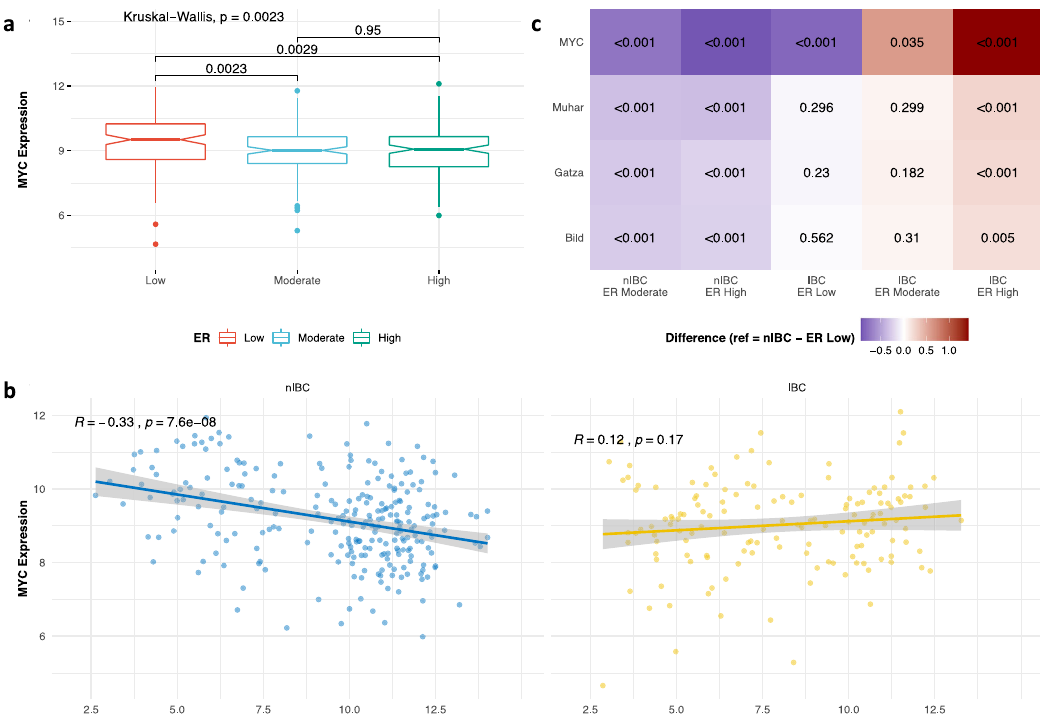
Fig. 4 MYC expression and transcriptional activity in patient samples in function of ESR1. a MYC expression levels (Y-axis) in a data set of 146 IBC and 252 nIBC tissue samples classi fi ed according to the ER status, calculated by stratifying ESR1 mRNA levels into low, moderate, and high categories. Data are represented in notched boxplot format and color-coding according to the legend shown underneath the plot. P values resulting from the pairwise comparison of the MYC expression distributions between the different tumor sample categories are indicated. b Scatter plot comparing ESR1 and MYC expression, represented in the X- and Y-axis respectively, in nIBC (left) and IBC (right) patient series. For each series, a trend line is plotted and the resulting Spearman correlation coef fi cients are shown in the top left corner. c Heatmap representing the result of a generalized linear regression analysis evaluating MYC expression levels (i.e., top row) and MYC transcriptional activation calculated using the gene sets published by Muhar et al., Gatza et al. and Bild et al. (i.e., bottom 3 rows) in function of the tumor phenotype (i.e., IBC vs. nIBC) and interactions thereof with different strata of ER expression. For each of the resulting categories, shown along the X-axis (i.e., nIBC — ER Moderate, nIBC — ER High, IBC — ER Low, IBC — ER Moderate, and IBC — ER High), regression coef fi cients representing the change in MYC expression or MYC transcriptional activity in that category relative to nIBC samples with low ER expression, are color-coded as shown in the legend. The heatmap for example shows that MYC expression (i.e., top row) in nIBC samples with high ER levels (i.e., 2nd column) decreases signi fi cantly (i.e., blue color) as compared to nIBC samples with low ER expression, whereas relative to the same category the MYC expression in IBC samples with high ER levels increases signi fi cantly. P values evaluating the signi fi cance of the changes are indicated in each